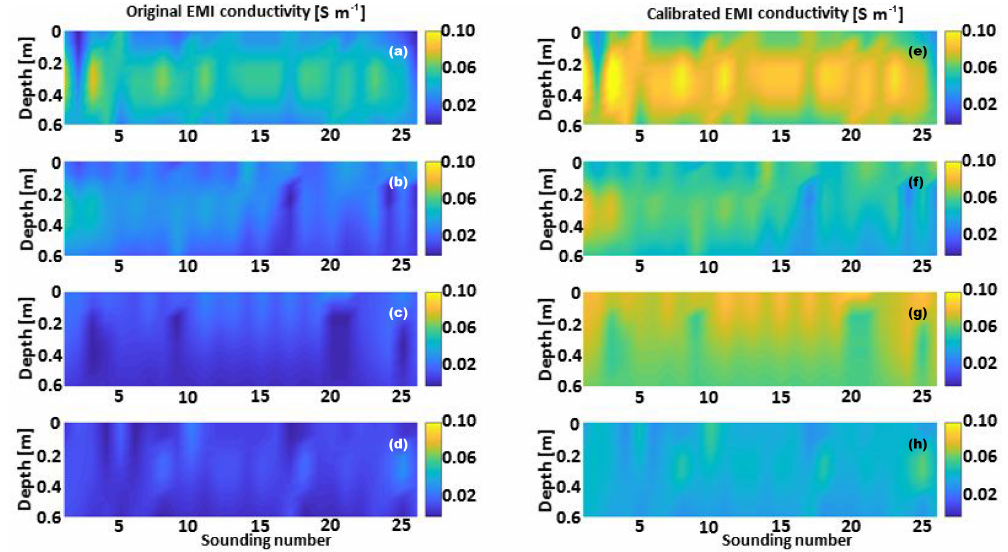
Figure 10. Maps of bulk electrical conductivity for the (a) 100-6dS, (b) 50-6dS, (c) 100-1dS and (d) 50-1dS transects showing the original σ b , EMI resulting from the inversion of the observed EMI data. (e) – (h) Show instead the corresponding results after the calibration via the TDR measurements (i.e., by applying Eq.